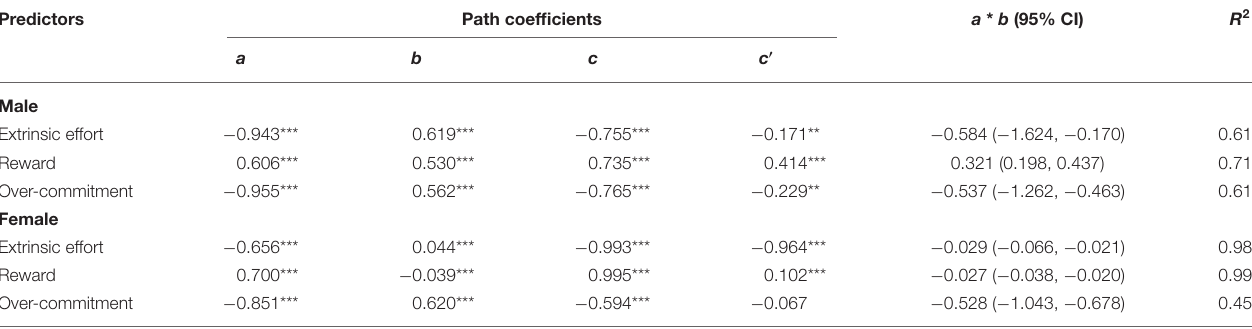
TABLE 5 | Regression analysis, using psychological capital as a mediator and personal accomplish as an outcome. Predictors